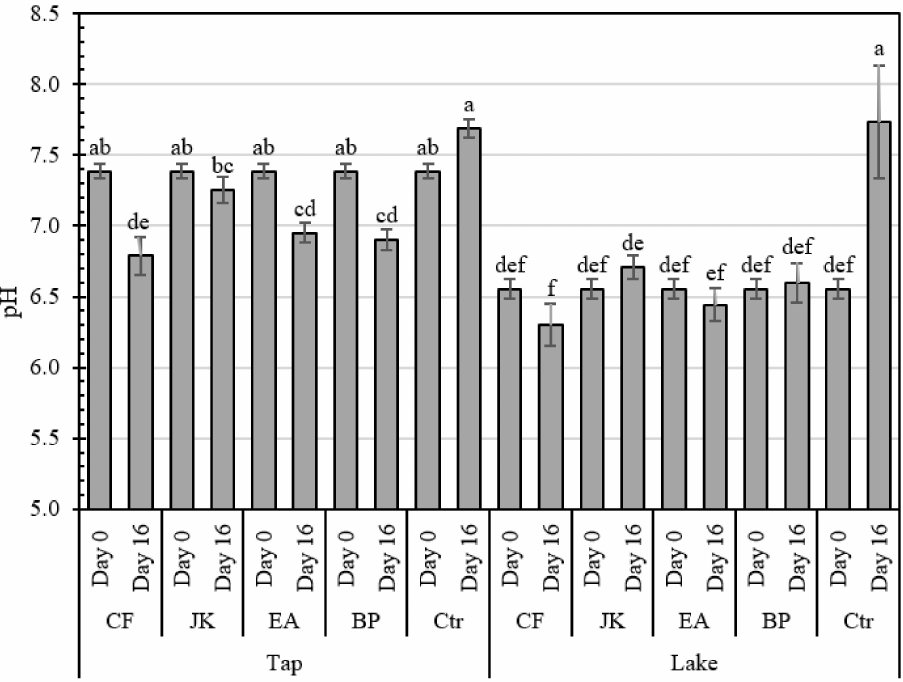
Figure 4. Variation of pH during experiments (with standard errors). pH values on day 0 and day 16 are the mean values of treatment-wise reactors (including high and low concentrations) on respective days. pH data followed normal distribution, and variance was homogeneous. One-way ANOVA with Duncan post-hoc analysis was performed. Values sharing a common letter label are not statistically